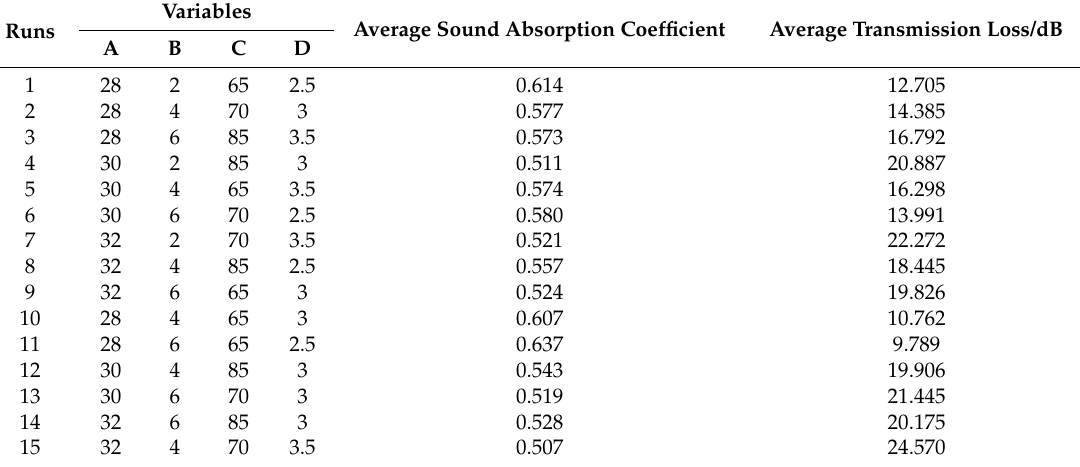
Table 3. Experiment design and experimental